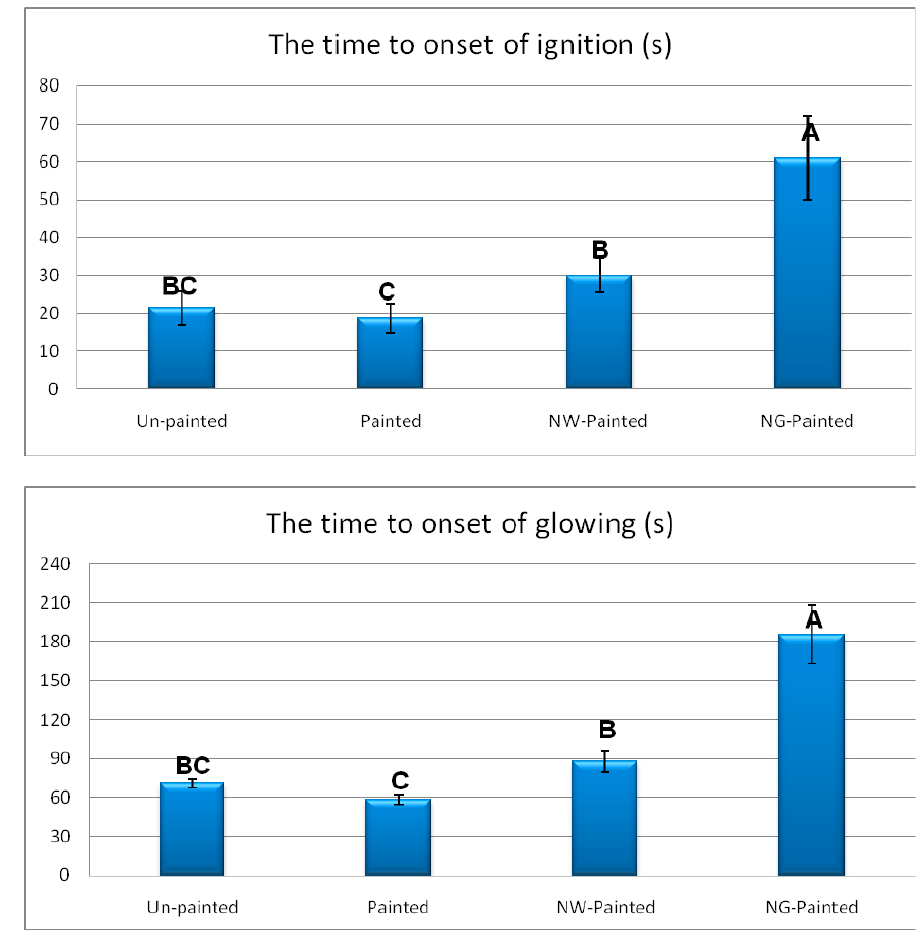
Figure 3. Time to onset of ignition and glowing, in the four treatments of beech specimens (NW = nanowollastonite; NG = nano-graphene) (Letters on each column represent Duncan groupings at 95% level of